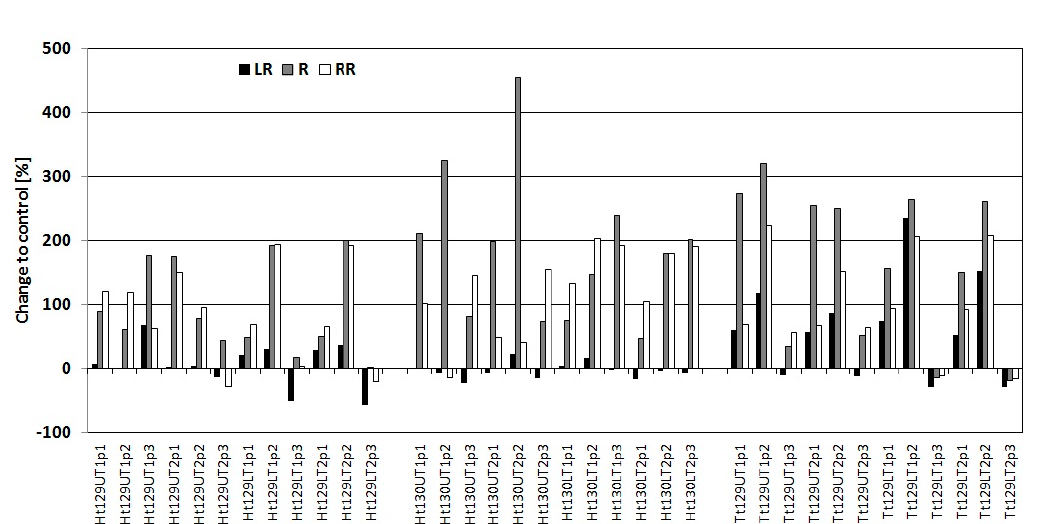
Figure 5. Increase in soil compactness PR on trails relative to control recorded for depths p1 (0.0–10 cm), p2 (10.1–20 cm), and p3 (20.1–30 cm).